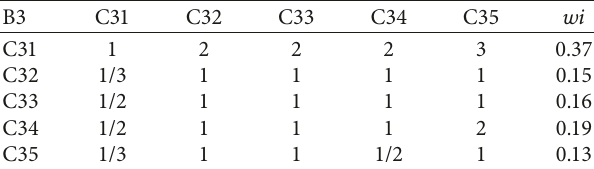
Table 10: Judgment matrix b3-c and index weights of layer C.